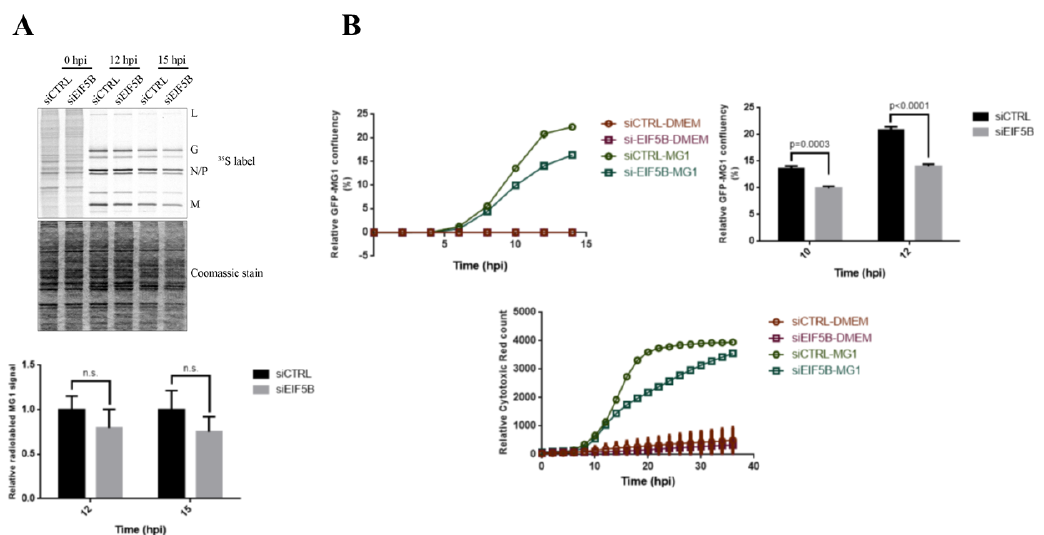
Figure 7. eIF5B knock-down affects the rate of MG1 infection and cytotoxicity. ( A ) Top: western blot from [ 35 S]-methionine labeling translational assay, U2OS cells were transfected with siCTRL or siEIF5B, followed by MG1 infection at MOI = 0.1 for 12 and 15 h. Bottom: Densitometry of M protein signal relative to Coomassie blue stain demonstrates the rate of MG1 mRNA translation at the indicated time points ( B ) Top left panel: U2OS cells were treated as in ( A ) and the rate of MG1 infection was monitored using IncuCyte Zoom live cell imaging. Y axis represents the percentage of GFP-MG1 infected cell relative to cell confluency. Top right panel: Fold confluency of GFP-MG1 signal at 10 and 12 hpi. Bottom panel: MG1 cytotoxicity was compared between the previously described conditions by monitoring signals from Cytotox Red reagent using IncuCyte Zoom. Y axis represents the number of cells emitting fluorescent red relative to cell confluency.